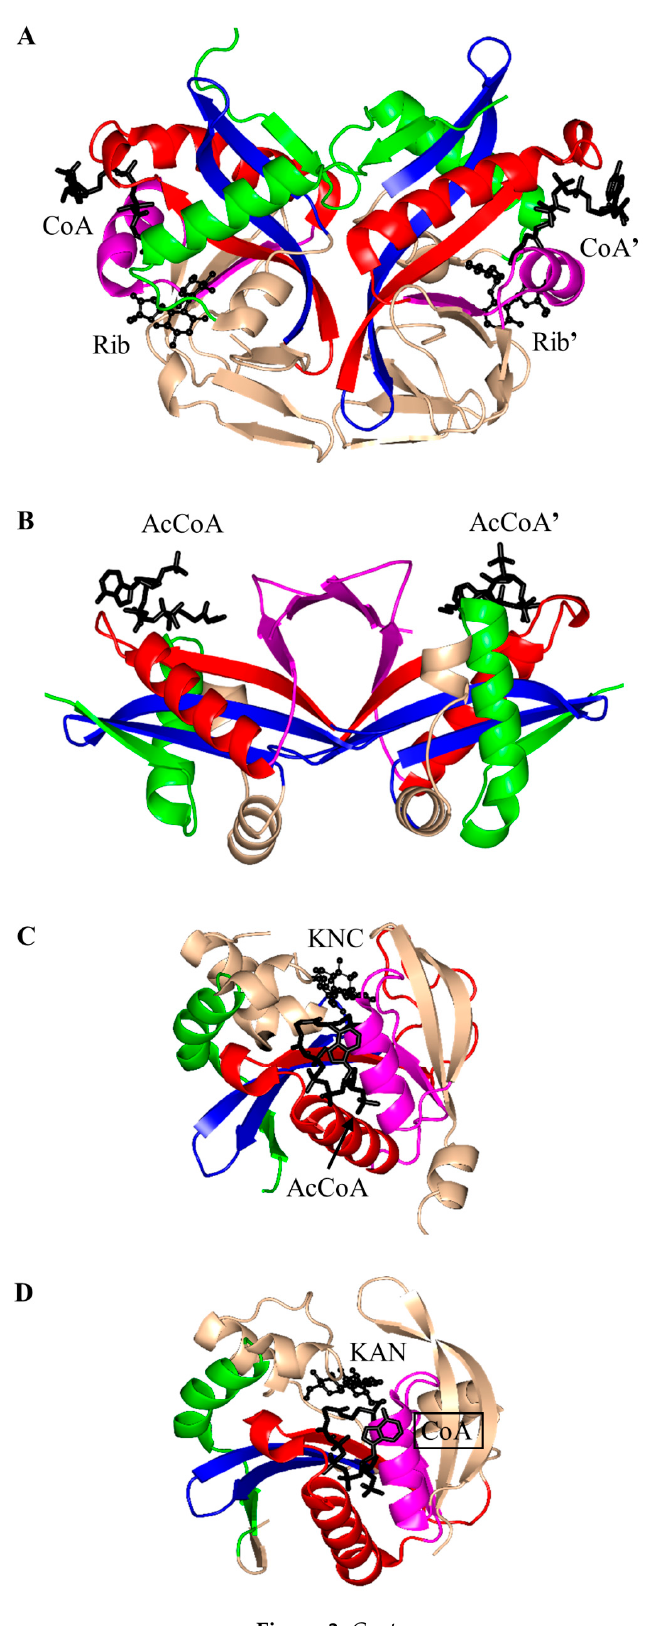
Figure 3. Cont. Figure 3.